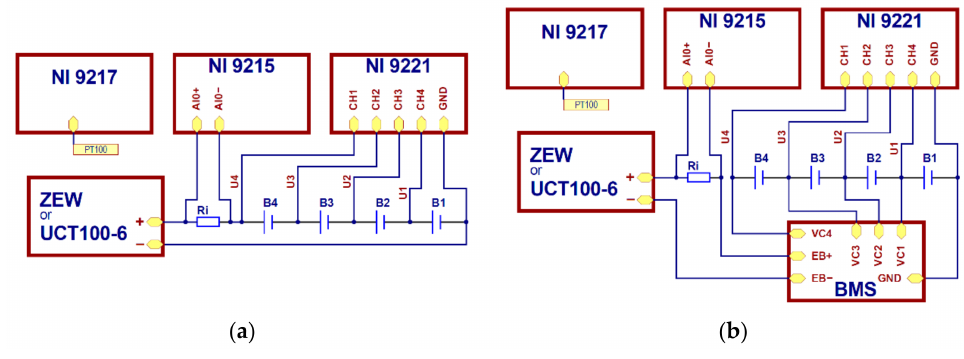
Figure 2. Measurement system: ( a ) without the BMS; ( b) with the BMS. U1 ÷ U4 voltage measurements were conducted using the NI 9221 module, while the NI 9215 module was used to measure U i on the R i resistor, whose resistance equals 10 m Ω . All the measurements were recorded every 5